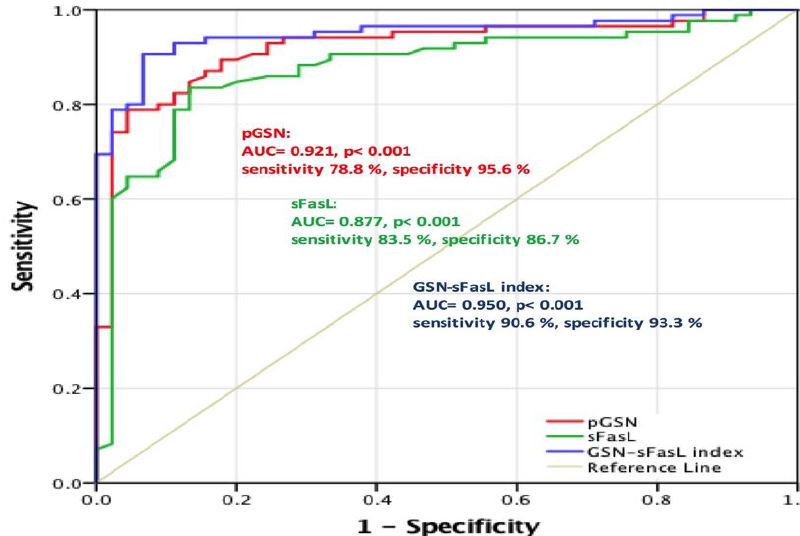
Figure 3. Receiver operating characteristic (ROC) curves of various candidate biomarkers in early HNC prediction. In 85 patients with HNC and 45 healthy controls, with optimal cutoff levels set at 106.13 μg/mL (determined using Fisher’s exact test), circulating pGSN demonstrated a 78.8% sensitivity and 95.6% specificity in early HNC prediction, whereas with optimal cutoff at 30.15 pg/mL, circulating sFasL exhibited an 83.5% sensitivity and 86.7% specificity in early HNC prediction. When pGSN and sFasL were combined to serve as an integrated predictive biomarker set (pGSN–sFasL index) for early HNC stage, with optimal cutoff levels set at 3614.07, the sensitivity and specificity were 90.6% and 93.3%, respectively. Moreover, in the multivariate index assay, pGSN–sFasL index could aid in discriminating patients at early HNC stages more effectively than in discriminating controls, with AUC >0.9 ( p < 0.001). Table 1. Sensitivity and specificity of pGSN, sFasL, or their combination in discriminating between early HNC stage and healthy groups.